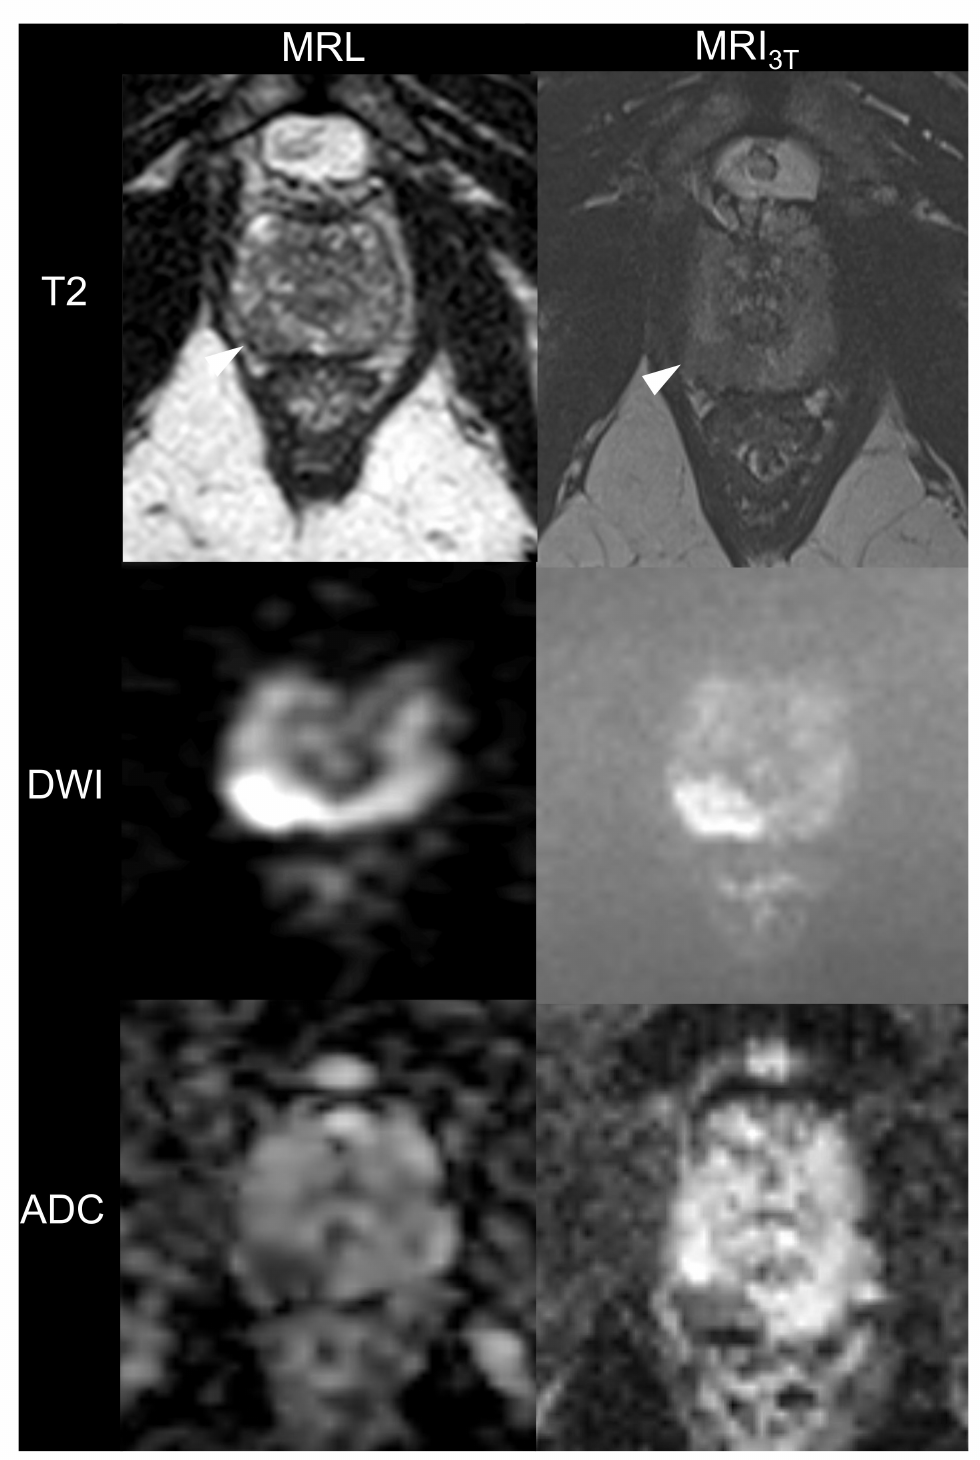
Figure 1. 60-year-old man with prostate-specific antigen level of 2.28 ng/mL and biopsy-confirmed prostate cancer. Axial T2-weighted images, diffusion-weighted images (DWI) and apparent diffusion coefficient (ADC) maps acquired with MR-Linac (MRL) operating at 1.5 T and corresponding images acquired on a standard 3T MRI (MRI 3T ). Note the hypointense region in the apical aspect of the right peripheral zone (arrows). Images generated with the MRI 3T have higher overall image quality, especially in the DWI. Histology of specimen yielded stage cT2a